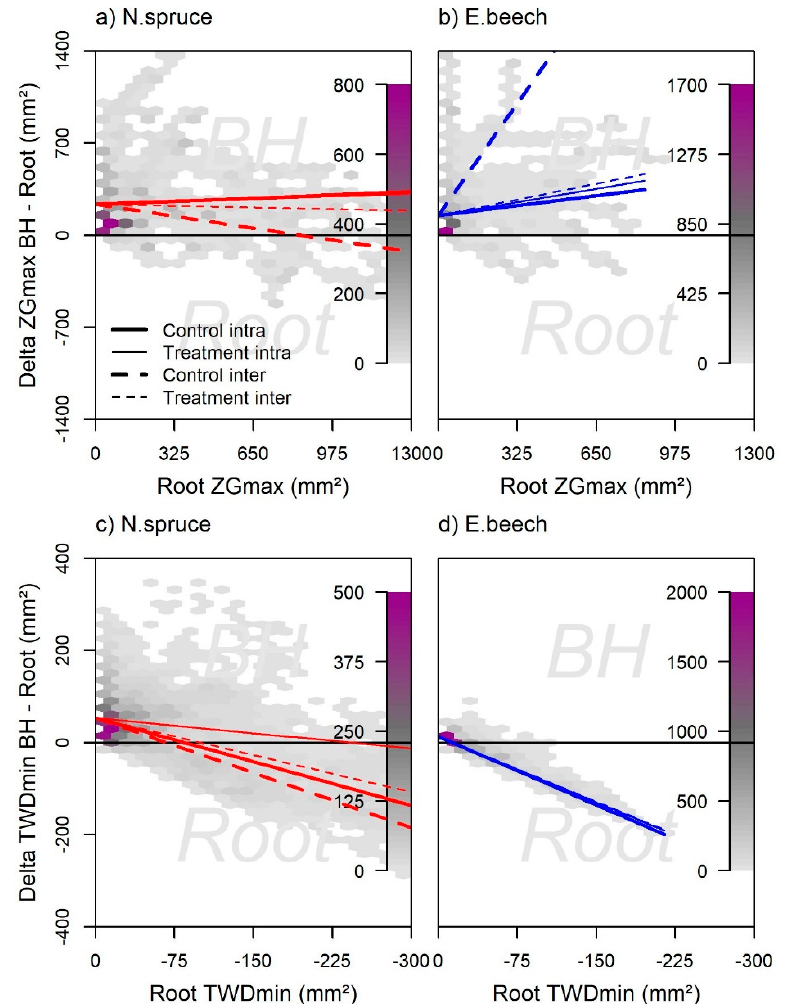
Figure 6. Relationship of growth (ZGmax) ( a , b ) and the tree water deficit (TWDmin) ( c , d ) represented by the difference of the measurements at breast height (BH) and at the roots, dependent on the root measurements. Values below the zero line mean a growth allocation into the roots. For the TWDmin, the negative values represent a lower tree water deficit in the roots. Linear mixed models depict how strongly the allocation is influenced by drought treatment (thick line—control, thin line—treatment) or mixture (intraspecific neighborhood—straight line, interspecific neighborhood—dashed line). The respective models are shown in Table 3.